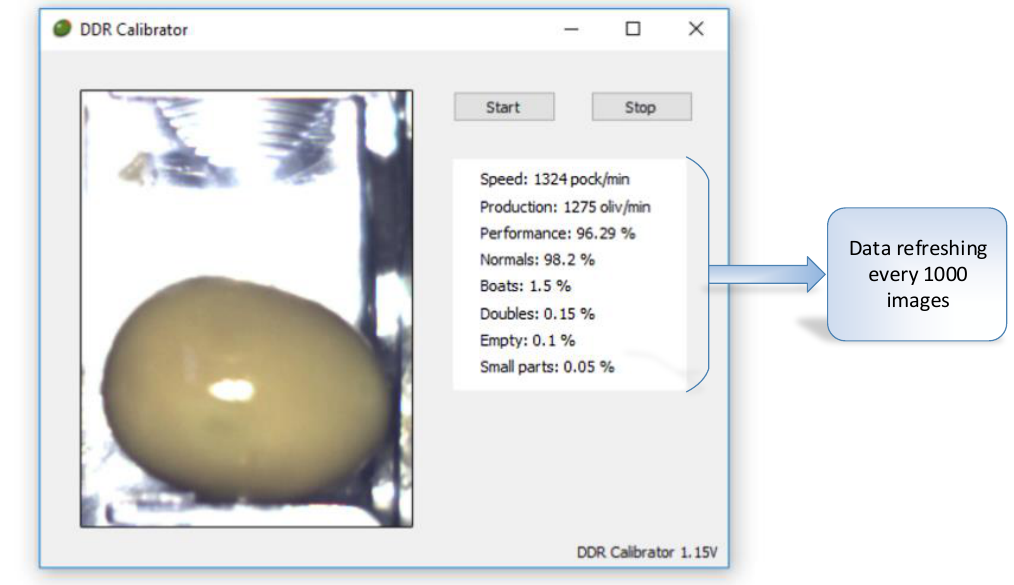
Figure 8. Qt Creator application for IoT management of olive pitting, slicing and stuffing (DRR) machines.